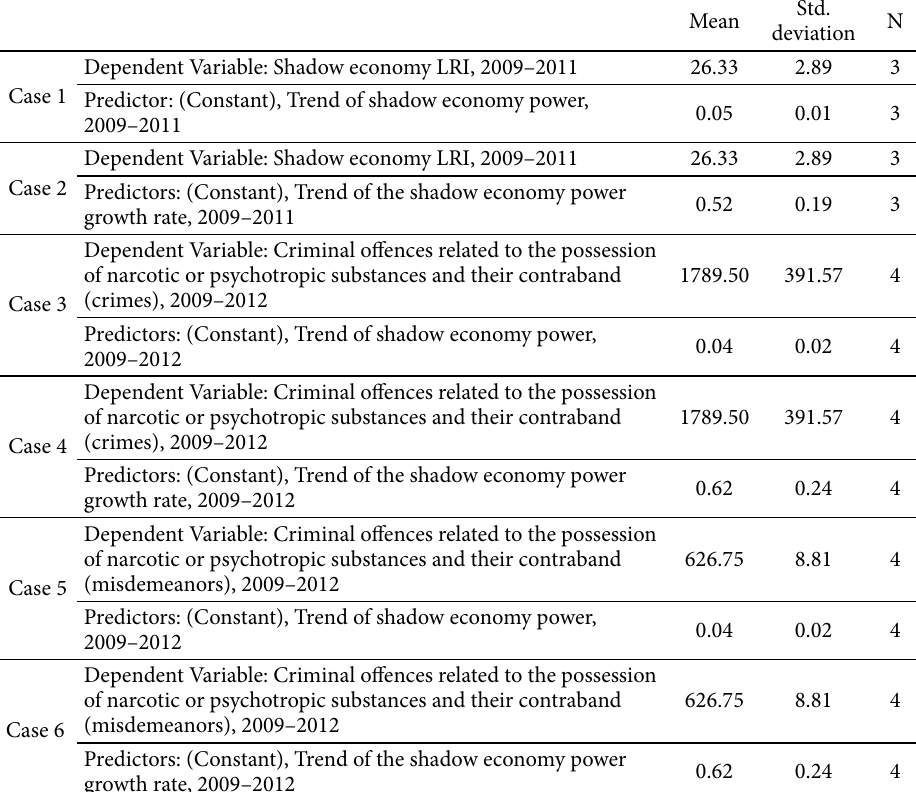
Std. N Mean deviation